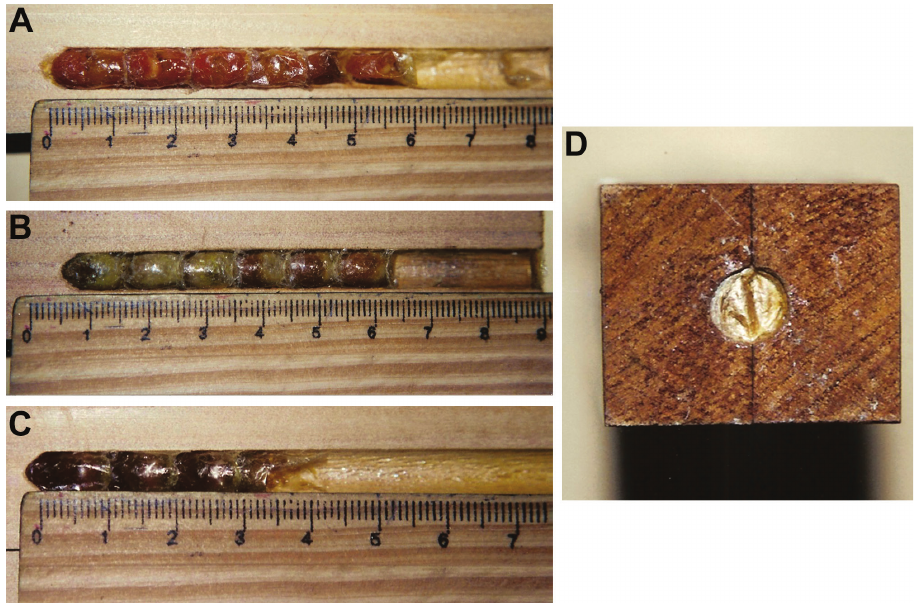
Figure 4. Nests of Mourecotelles braziliensis built in wooden trap nests A food provision looks bright orange when relatively fresh B brood cells become darker as larvae start to defecate (~26 days after hatch) C brood cells turn nearly black due to accumulation of larval feces (~31 days after hatch) D entrance of a TN07 plugged with cellophane-like